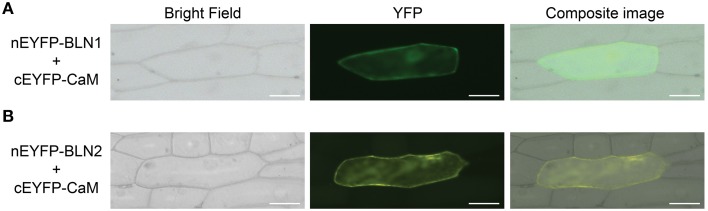
Bimolecular fluorescence complementation (BiFC) assay for interaction between BLN1/2 and CaM. The Bln1 and Bln2 full length ORFs were PCR-amplified and cloned into EcoRI-BamHI sites of EcoRI-BamHI sites of pSAT4-nEYFP-C1 or pSAT4-cEYFP-C1 to generate pSAT4-nEYFP-Bln1, pSAT4-nEYFP-Bln2, pSAT4-cEYFP-CaM respectively. The designated plasmid combinations were co-bombarded into onion epidermal cells. The bright-field and fluorescent images were taken using the Zeiss Axiovert 100 microscope equipped with appropriate YFP filter. Statistical analysis of YFP count data is presented in Table 3. (A) Microscopic observation for interaction between BLN1 and CaM. (B) Microscopic observation for interaction between BLN2 and CaM.